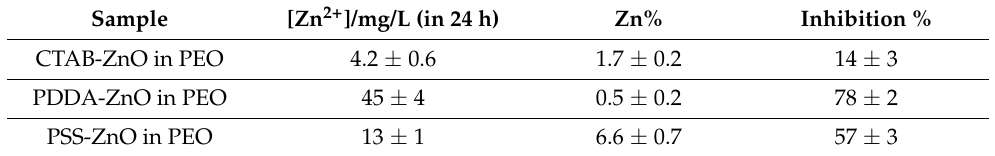
Figure 5. Effectiveness of composite coatings based on PEO, embedding CTAB-, PDDA-, and PSS- capped ZnONPs. Antigen quantification was performed after 24 h of contact. Data were averaged across three replicates, with corresponding standard deviations. Control experiments on bare PEO did not show any change in antigen quantification. Table 2. Correlation among the Zn 2+ ionic release in solution (after 24 h of contact, second column), the zinc surface atomic percentage (Zn%, as determined by XPS analysis, third column), and the inhibition efficiency (estimated through the N protein antigen quantification, last column). Data are reported as mean values ± 1 standard deviation over three independent